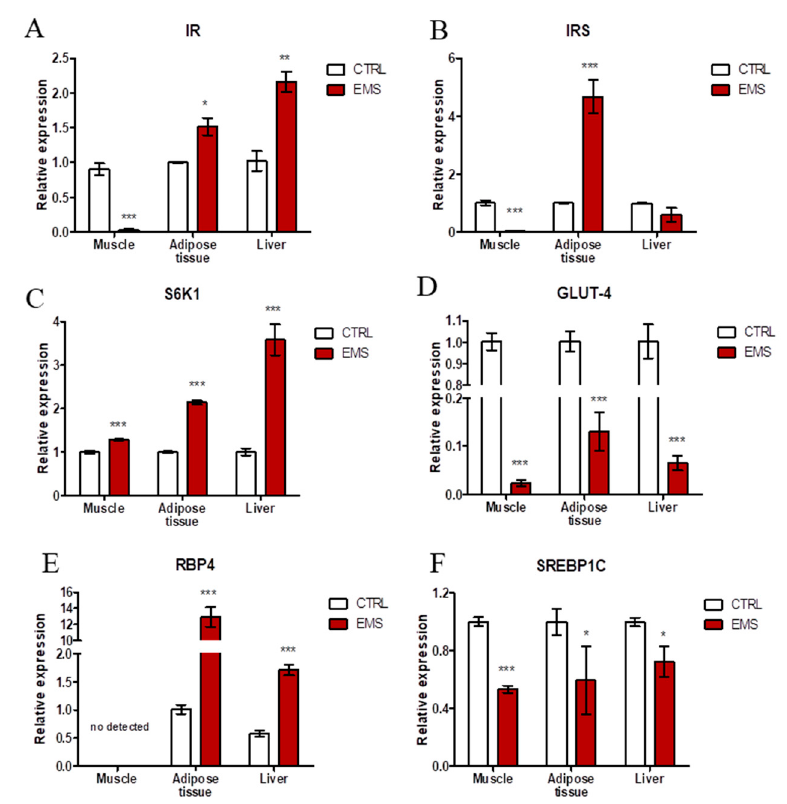
Figure 2. Expression of insulin resistance-related genes in muscle, adipose tissue and liver of horses. Using RT-PCR, the expression of IR ( A ), IRS ( B ), S6K1 ( C ), GLUT-4 ( D ), RBP4 ( E ) and SREBP1C ( F ) was investigated. Results expressed as the mean ± S.D. * p < 0.05, ** p < 0.01, *** p < 0.001.